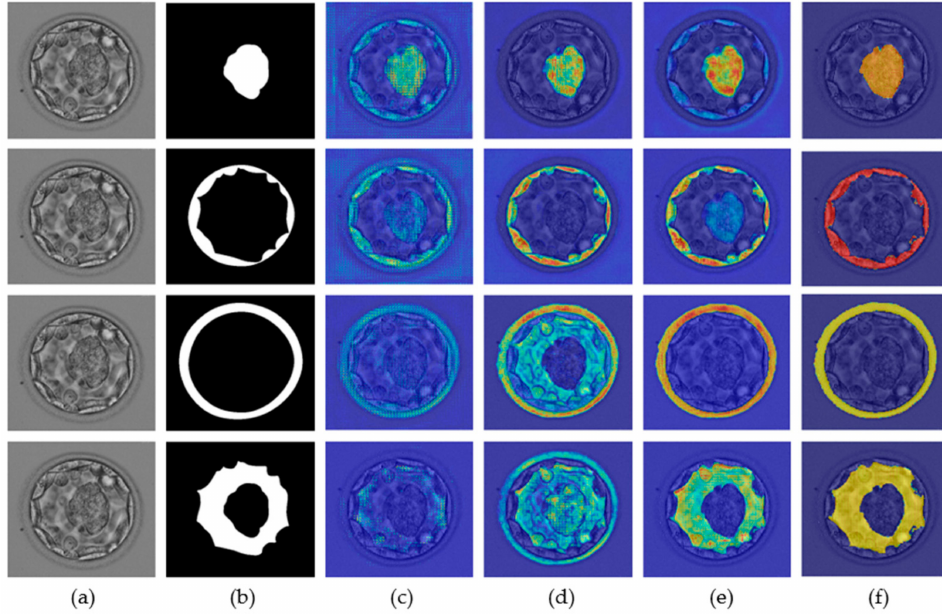
Figure 7. MASS-Net Grad-CAM visualization for ICM (row-1), TE (row-2), ZP (row-3), and BL (row-4): ( a ) original blastocyst microscopic image, ( b ) expert annotation, and Grad-CAM obtained from the ReLU of ( c ) S2-Tconv-B, ( d ) US-Conv-A, ( e ) US-Conv-B, and ( f ) US-Tconv-A.